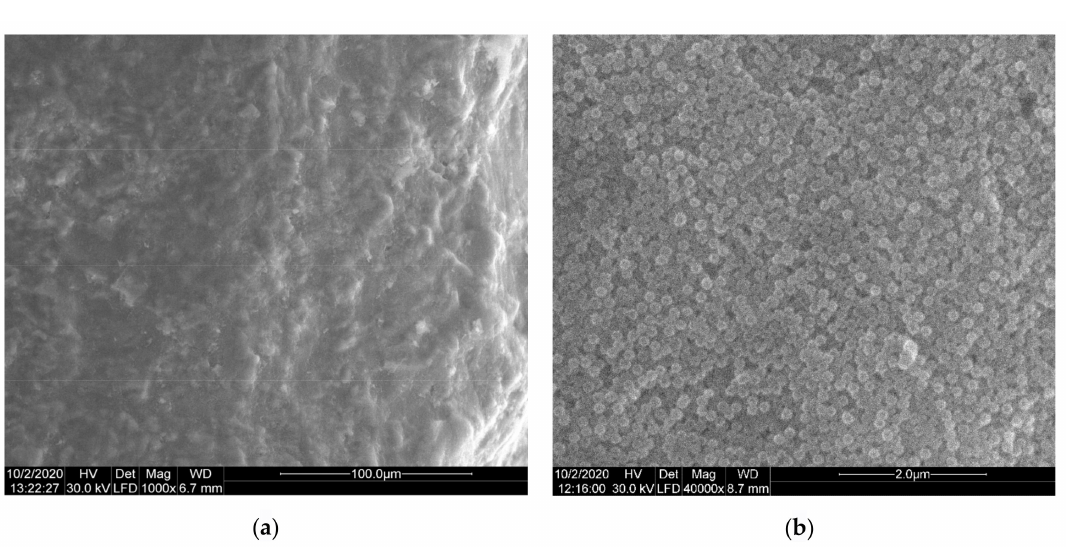
Figure 8. SEM images of the travertine sample: pristine stone ( a ); travertine coated with TEOS / O 8 TES hybrid material ( b